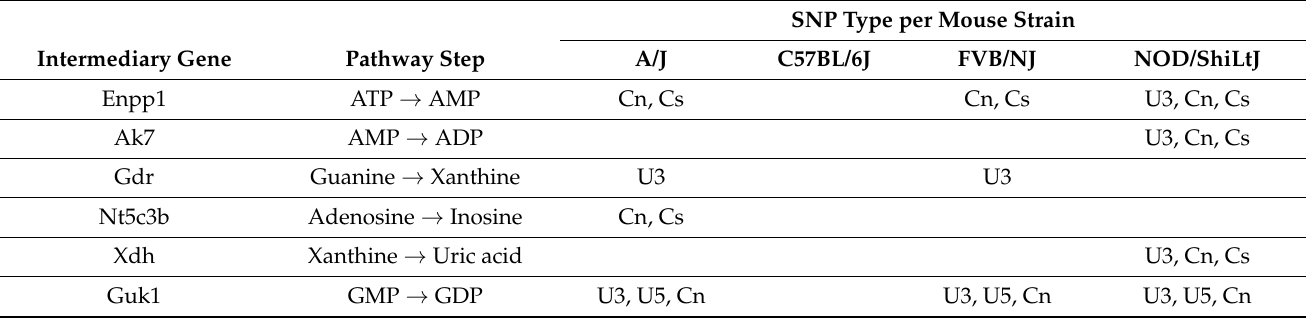
Table 3. SNPs across mouse strains reveal genetic